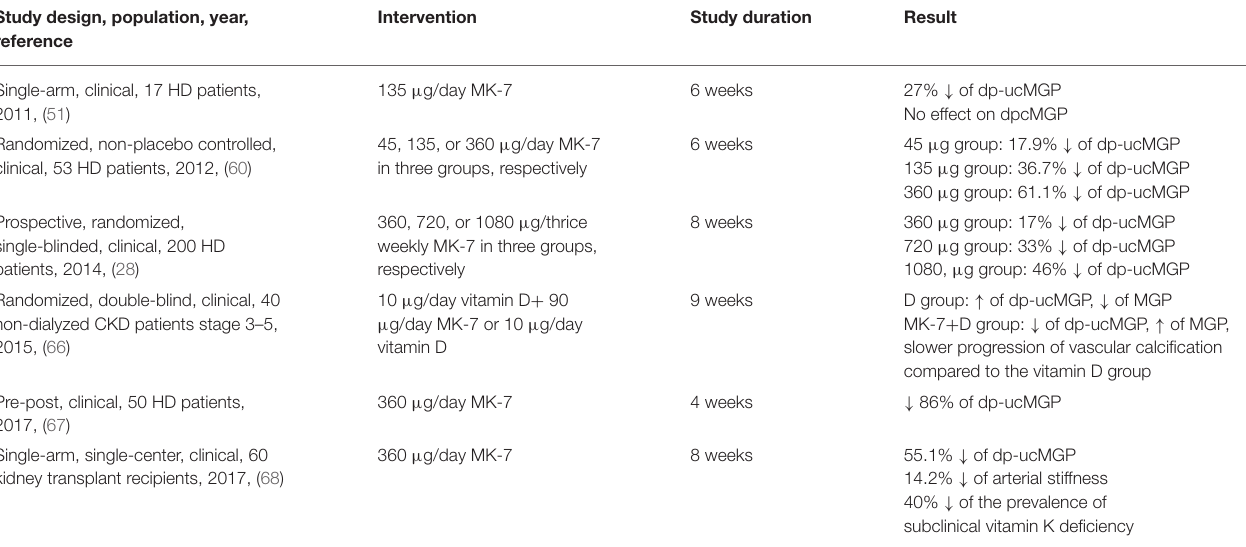
Intervention Study duration Result